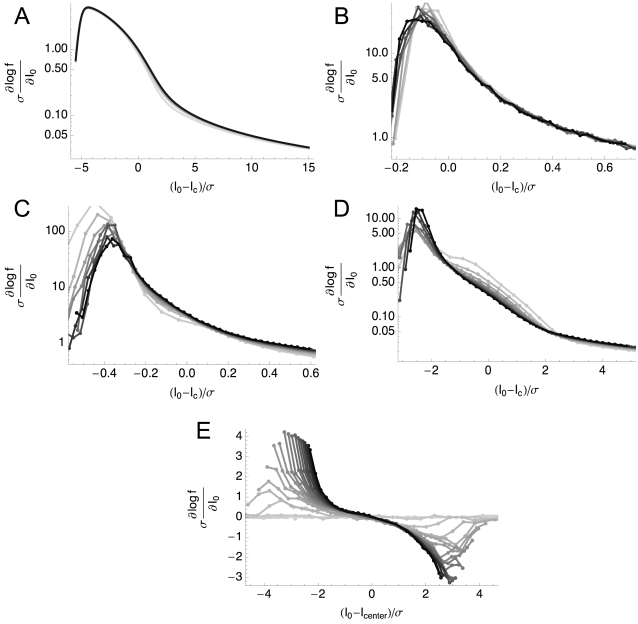
Rescaled Relative Gains of Variance-Dependent f-I Curves.(A) The one-dimensional LN, (B) QIF, and (C) LIF models. The same data as Figure 2 are used. (D) The standard HH model from Figure 1A and 1B. (E) The HHLS model from Figure 1C and 1D. Since the HHLS does not have a rheobase, we instead used I
center = 20 nA at which the variance-dependent firing rate increase is maximal.